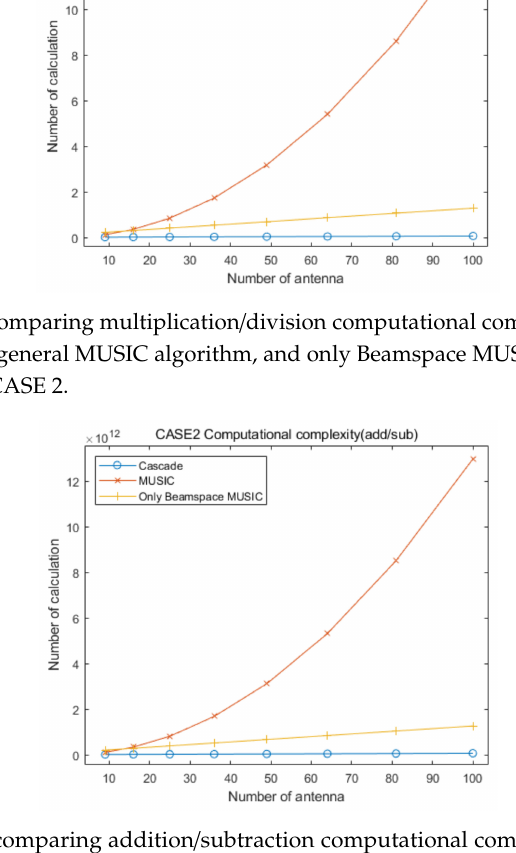
Figure 24. Curves for comparing addition / subtraction computational complexities of the proposed cascade algorithm, the general MUSIC algorithm, versus the number of antenna elements, for CASE